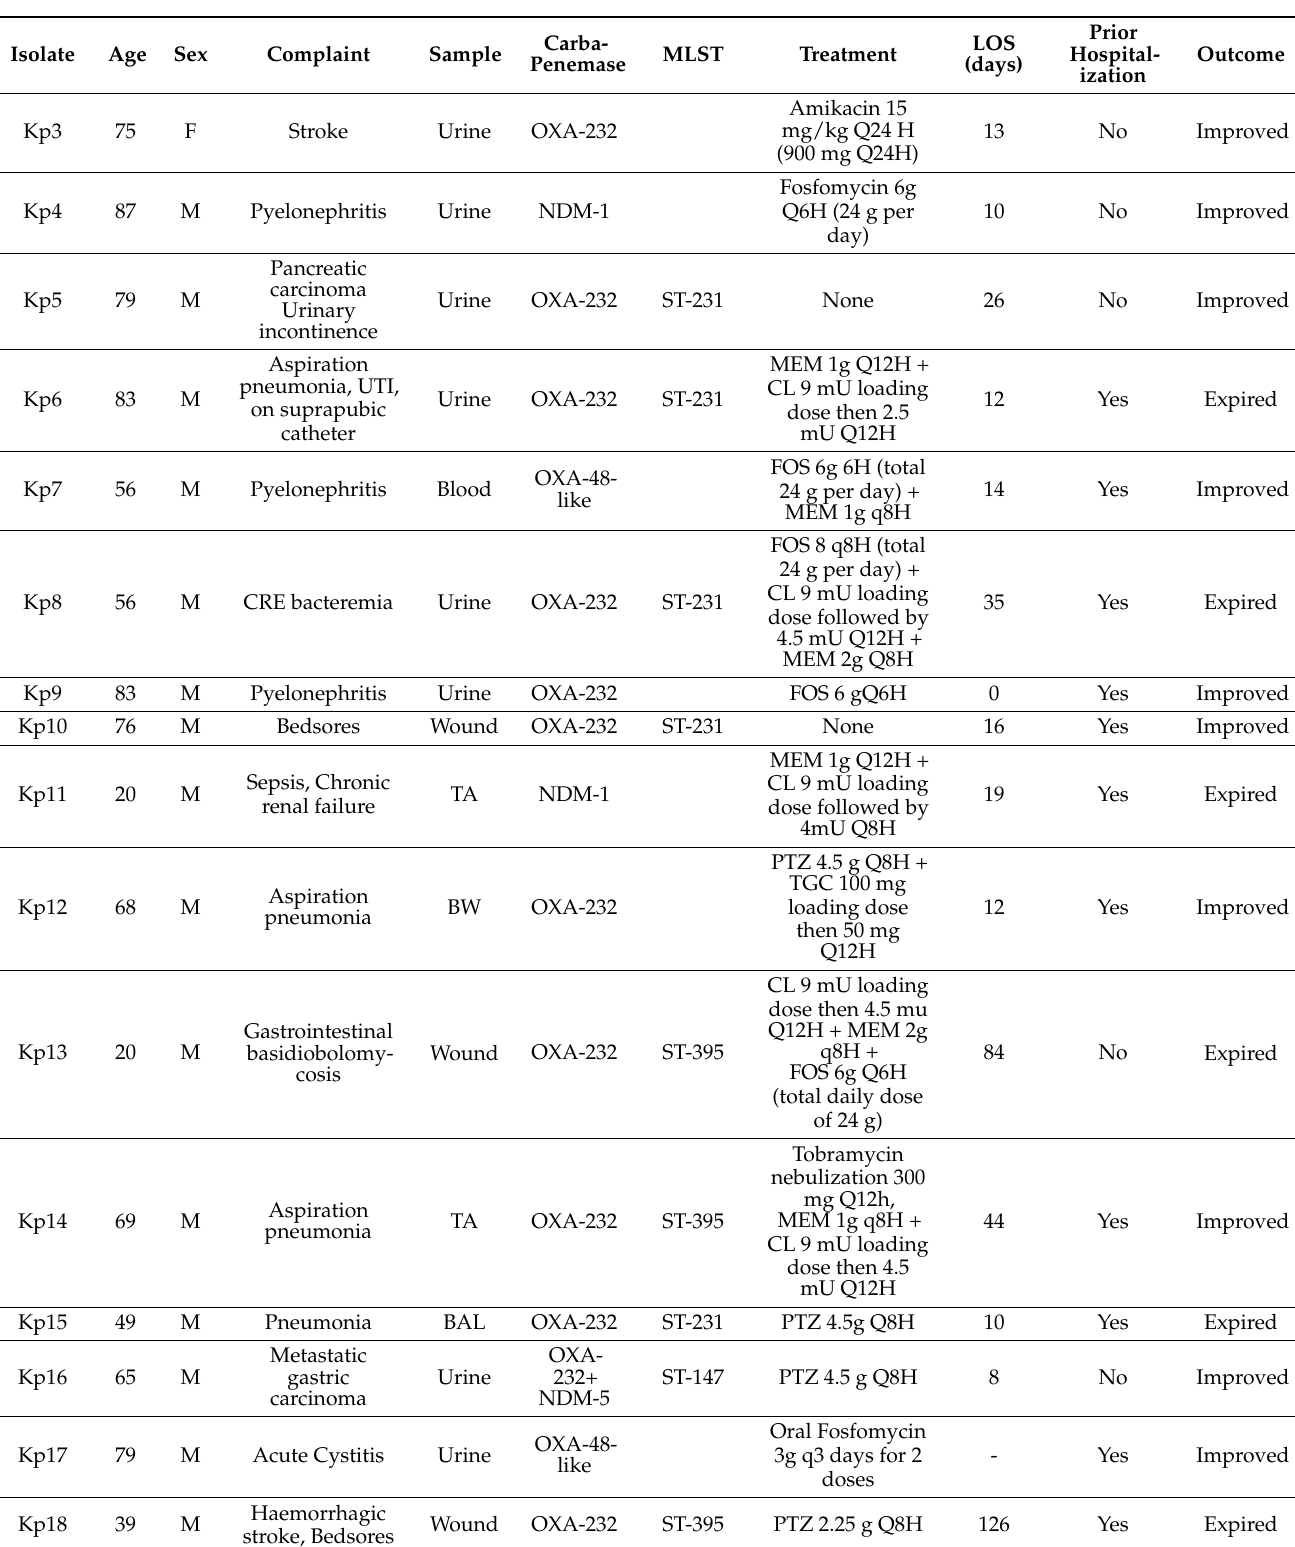
Abbreviations: LOS: Length of stay, BW: Bronchial wash, TA: tracheal aspirate, M: male, F: female, AK: amikacin, CL: colistin, MEM: meropenem, SXT: cotrimoxazole, FOS: fosfomycin, PTZ: Piperacillin-tazobactam UTI: urinary tract infection, BAL: Bronchoalveolar